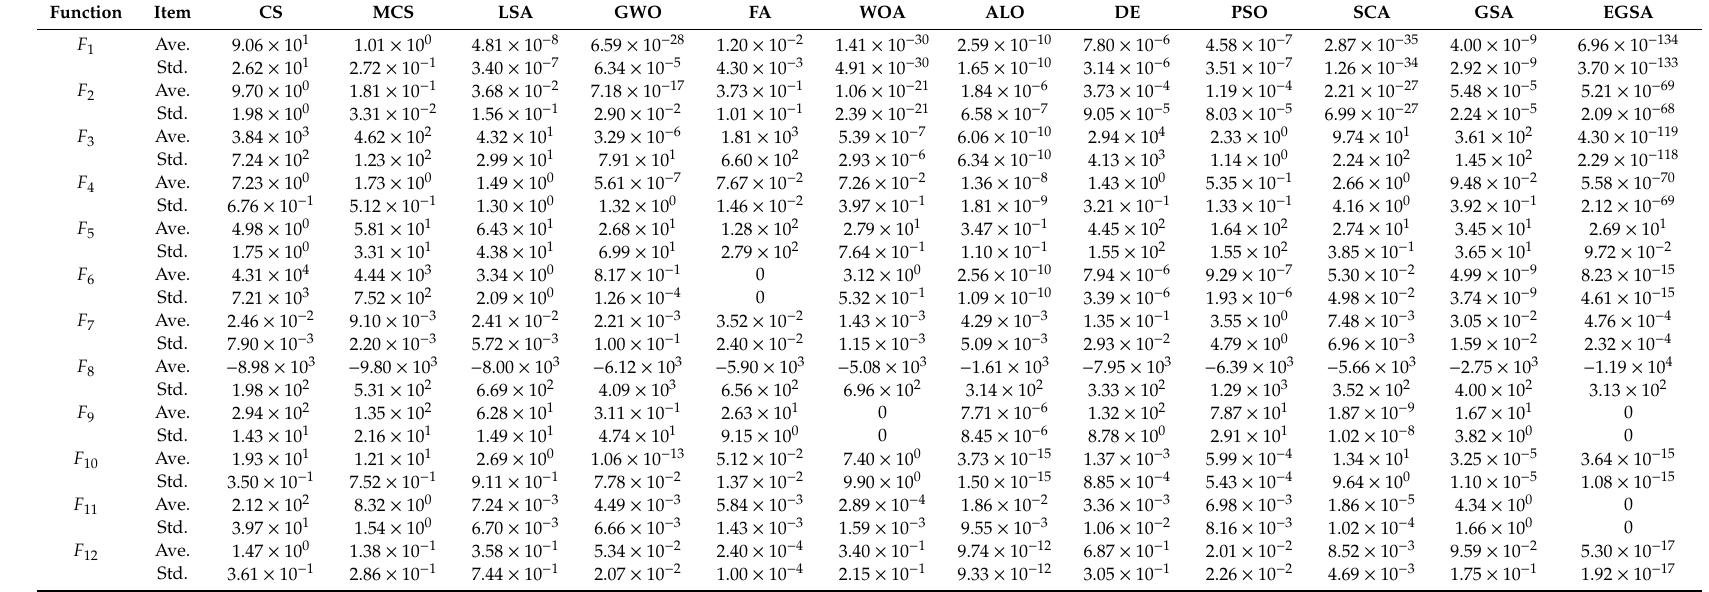
Table 2. Statistical indexes of 12 algorithms for all the test